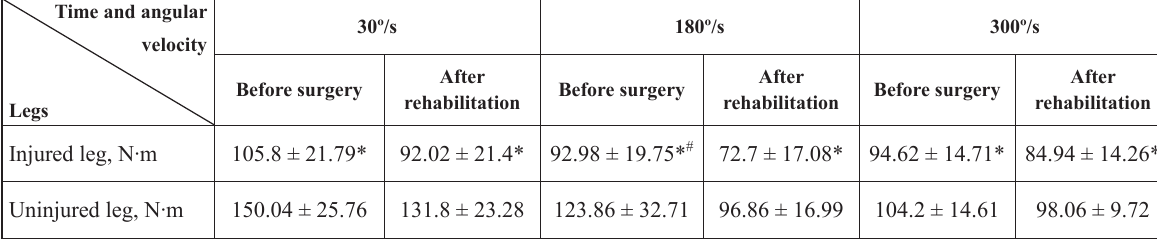
Note. * – p < 0.05 between injured and uninjured legs; # – p < 0.05 difference before surgery and after rehabilitation. Table 3. Isokinetic fl exion torque of injured and uninjured legs before surgery and after rehabilitation